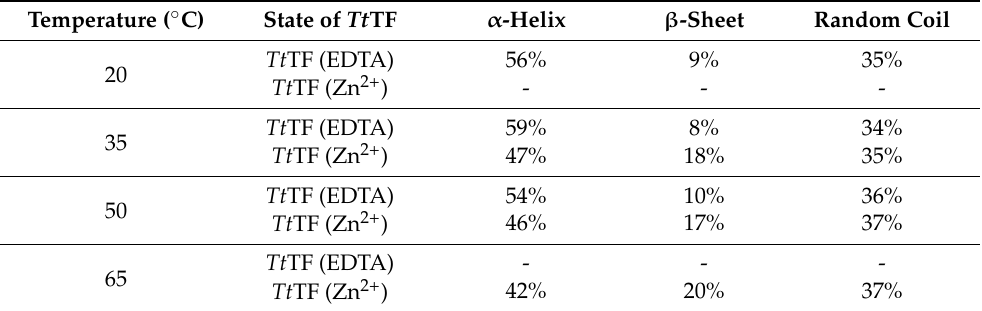
Table 2. Summary of the secondary structure contents of Tt TF in the absence and presence of Zn 2+ at 20 ◦ C, 35 ◦ C, 50 ◦ C, and 65 ◦ C. The fitting failed for the Data of Tt TF (Zn 2+ ) at 20 ◦ C and Tt TF (EDTA) at 65 ◦